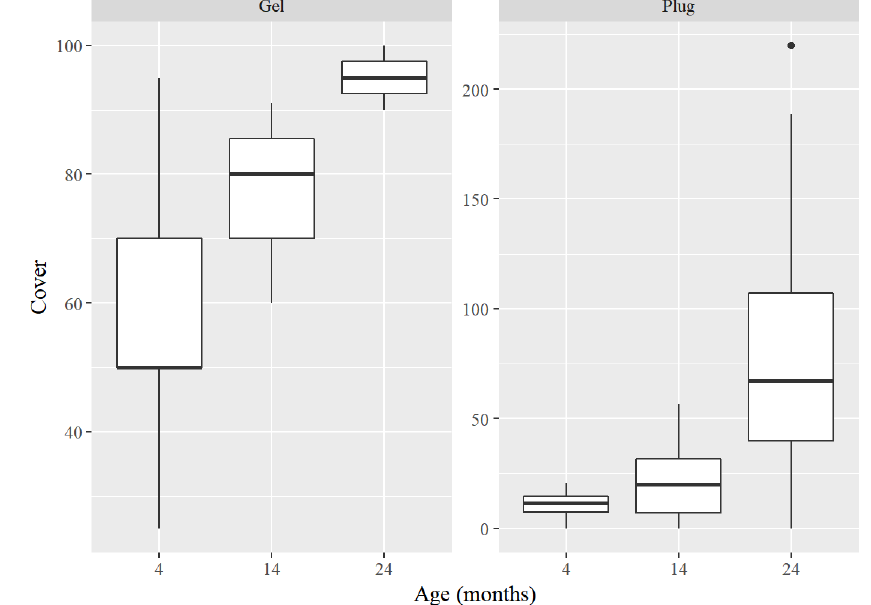
Figure 7. Sphagnum cover (% and cm 2 , respectively) of plots of different ages, following application of BeadaGel ™ (left) and BeadaHumok™ (right) in June 2014 to lowland peatland after site re-wetting and spontaneous growth of E. angustifolium , as shown in Figure 2b (Trial